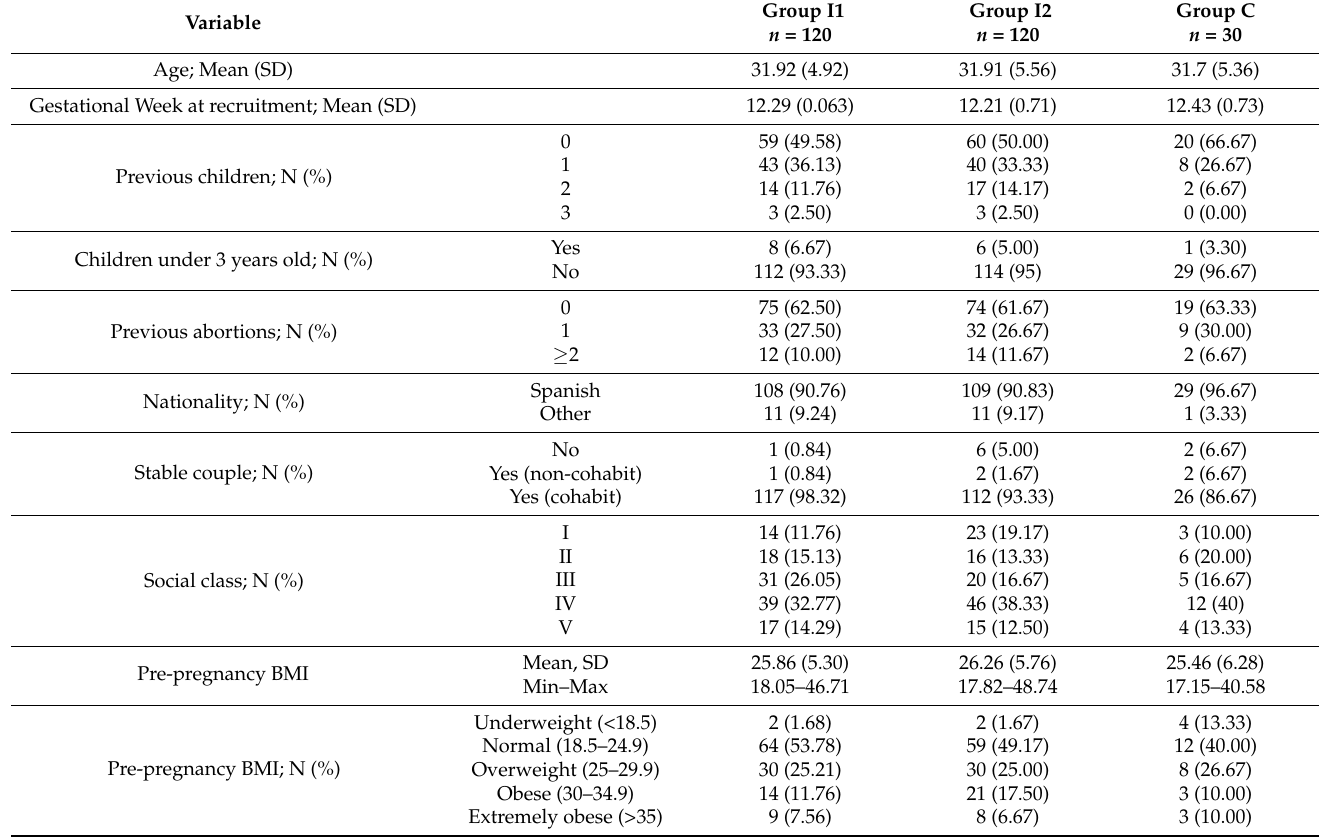
Table 1. Baseline characteristics of participants in the WPP.